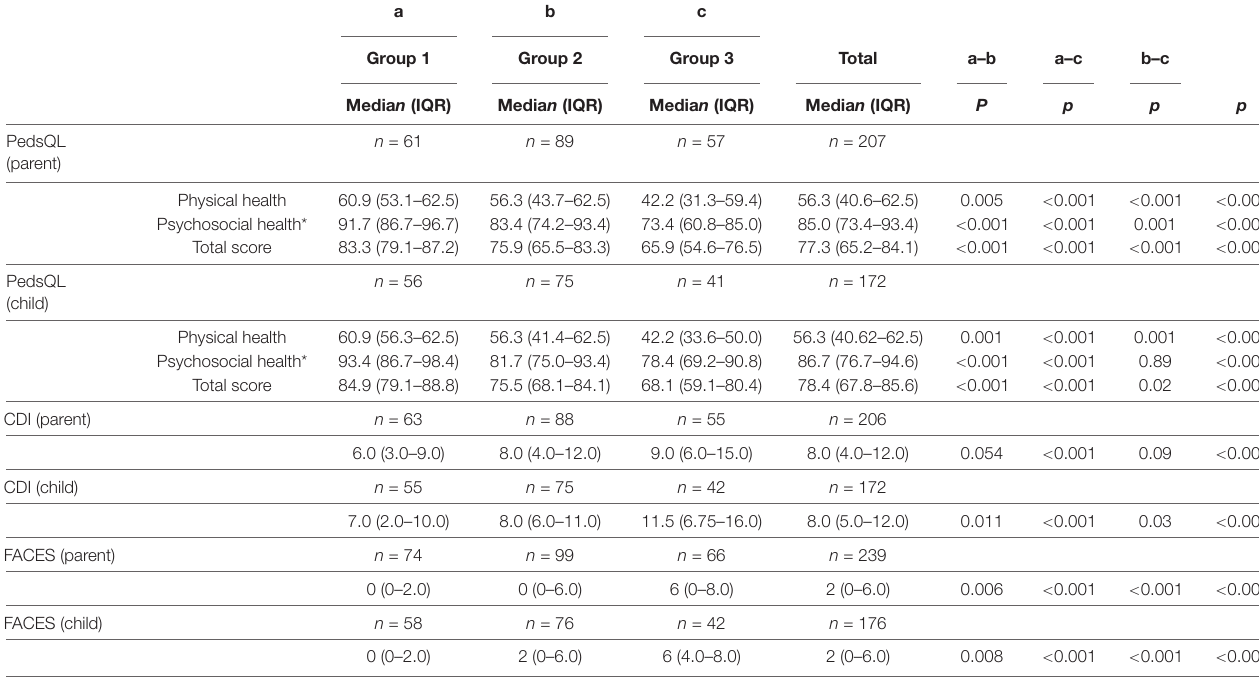
TABLE 3 | The comparisons of the scores of PedsQL, FACES, and CDI among groups by the number of FMF episodes.